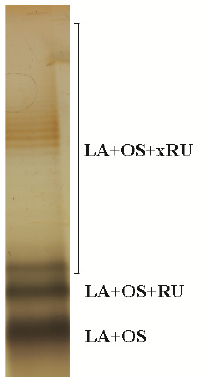
Figure 1. SDS/PAGE analysis of the lipopolysaccharide isolated from P. shigelloides O24 (CNCTC 92/89). The bands were visualized by silver-staining. LA-lipid A, OS-core oligosaccharide, RU-repeating